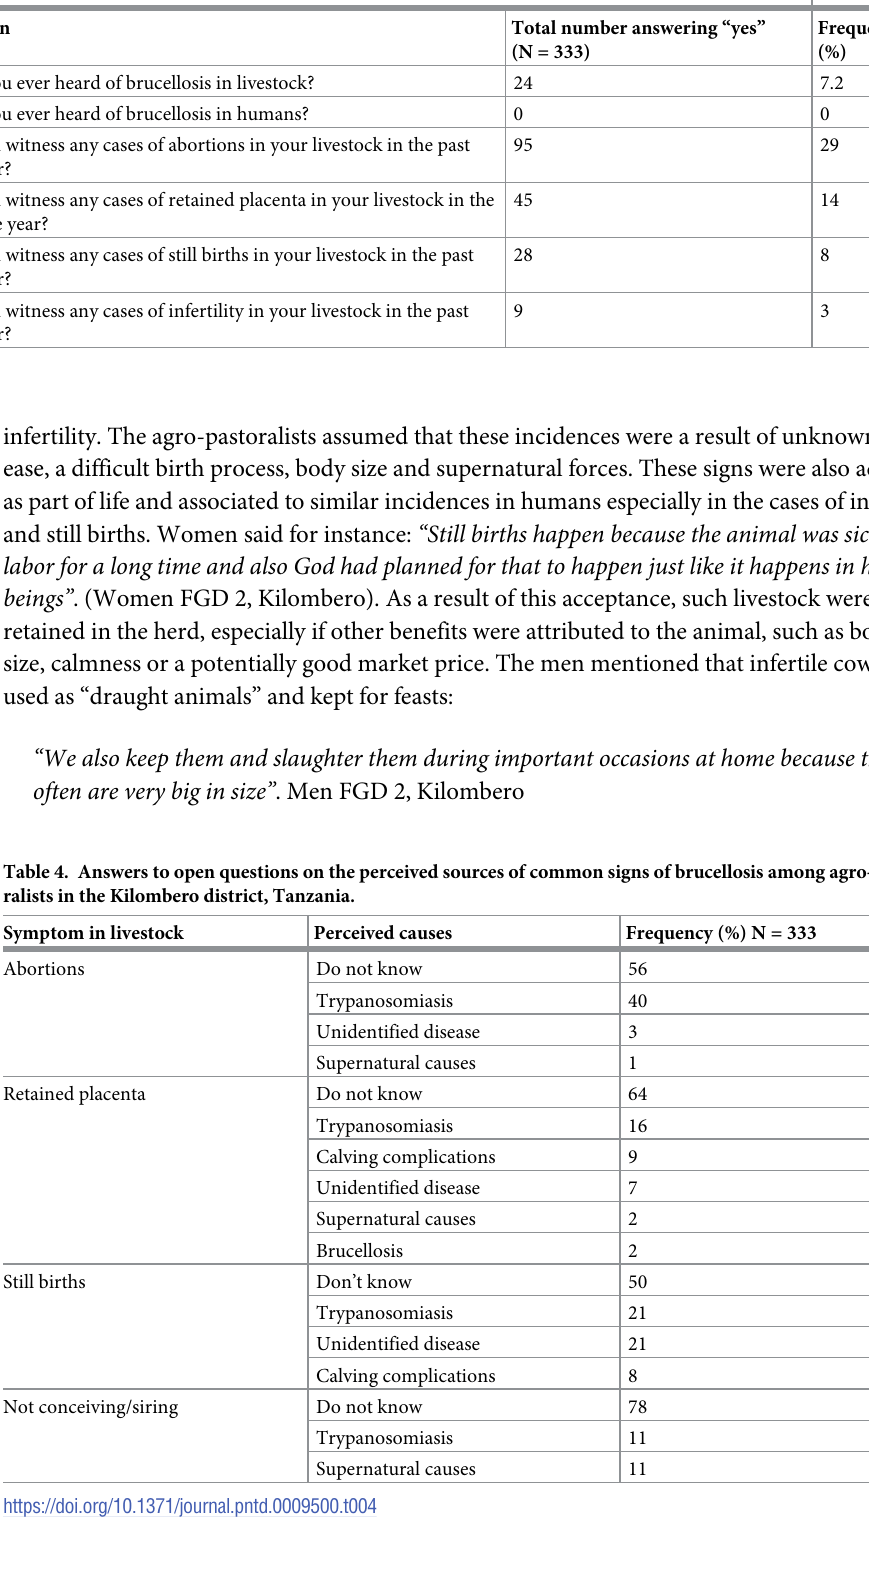
Table 3. The awareness and experience of symptoms related to brucellosis among agro- pastoralists in the Kilombero district, Tanzania. Awareness